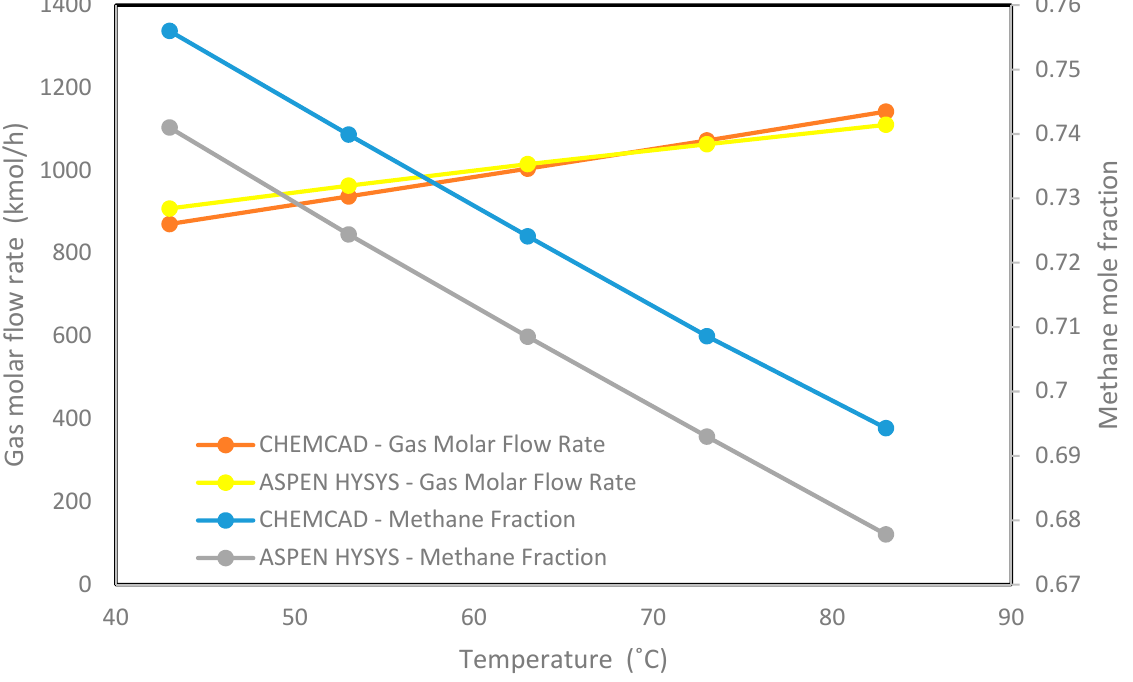
Figure 7. The produced methane mole fraction and the gas molar flow rate in CHEMCAD and Aspen HYSYS.